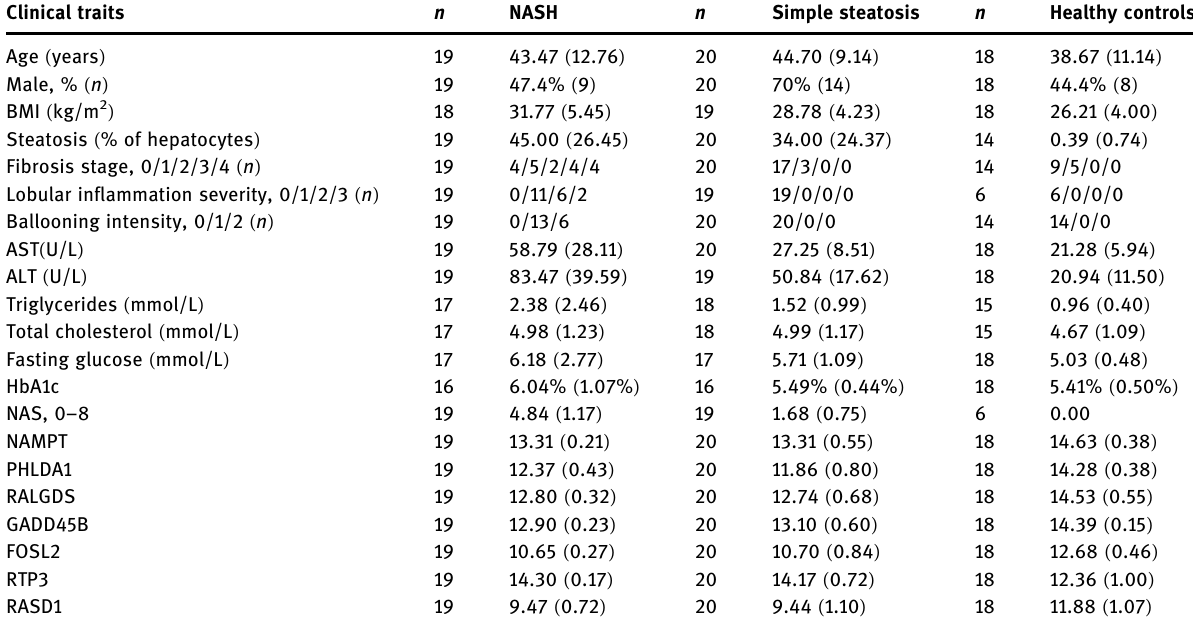
Table 2: Clinical data and the expression of hub genes in dataset GSE89632. Values given are mean ( SD ) or numbers of valid cases Clinical traits